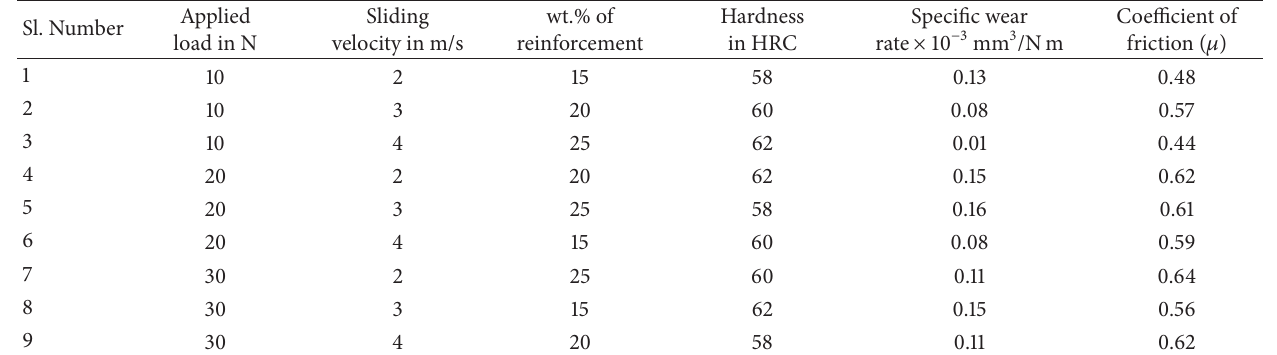
Table 6: Experimental runs and results.